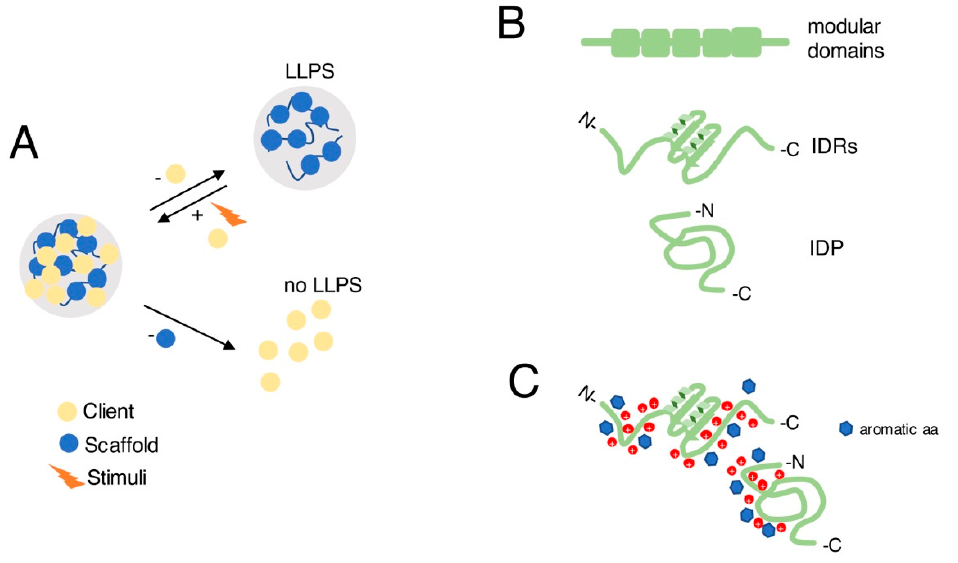
Figure 2. Factors contributing to LLPS condensates formation. ( A ) Scaffold (blue circles) and client (yellow circles) components of LLPS condensates and their role in condensate formation. Clients bind scaffold elements in a regulated way, and their composition varies in response to stimuli (orange lightning). Clients are dispensable for the assembly of the condensate; otherwise, scaffold elements are necessary to assemble a LLPS condensate. ( B ) Three classes of proteins contribute to LLPS: proteins containing repetitions of modular domains (green boxes); proteins that contain ordered and intrinsically disordered regions (IDRs; green); intrinsically disordered proteins (IDPs). ( C ) Examples of non-covalent pi-cation interactions between aromatic residues (blue hexagons) and cations (red circles) of positively charged amino acids that could account for LLPS formation by proteins with